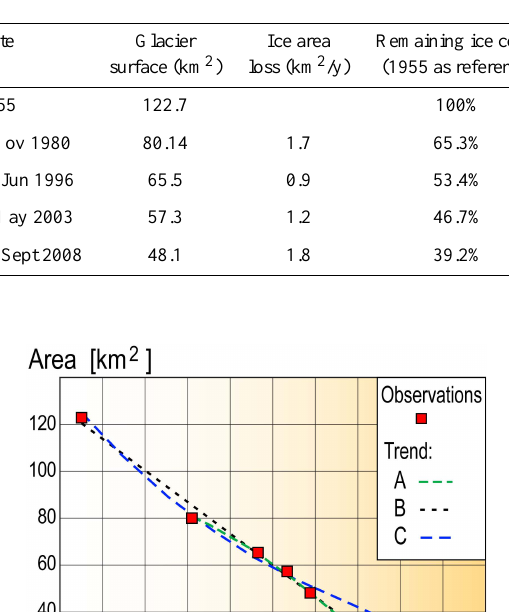
Table 6. Evolution of ice cover.